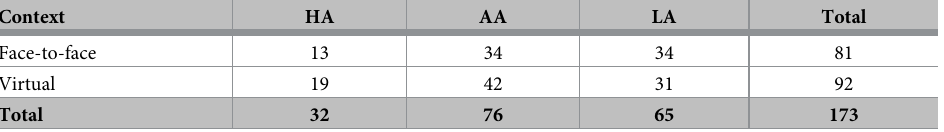
Table 1. Number of students participating in the work, divided according to their final achievements K contexts.